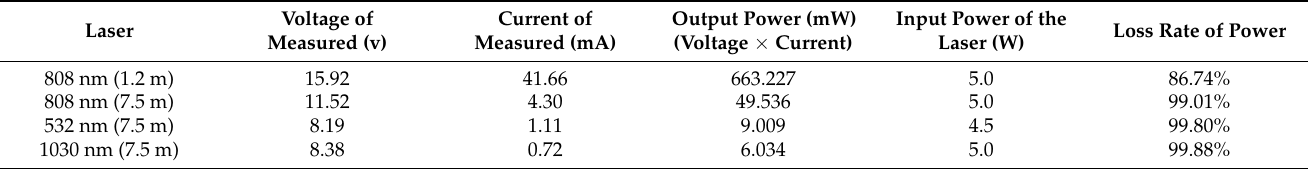
Table 6. The total output voltage, current, and